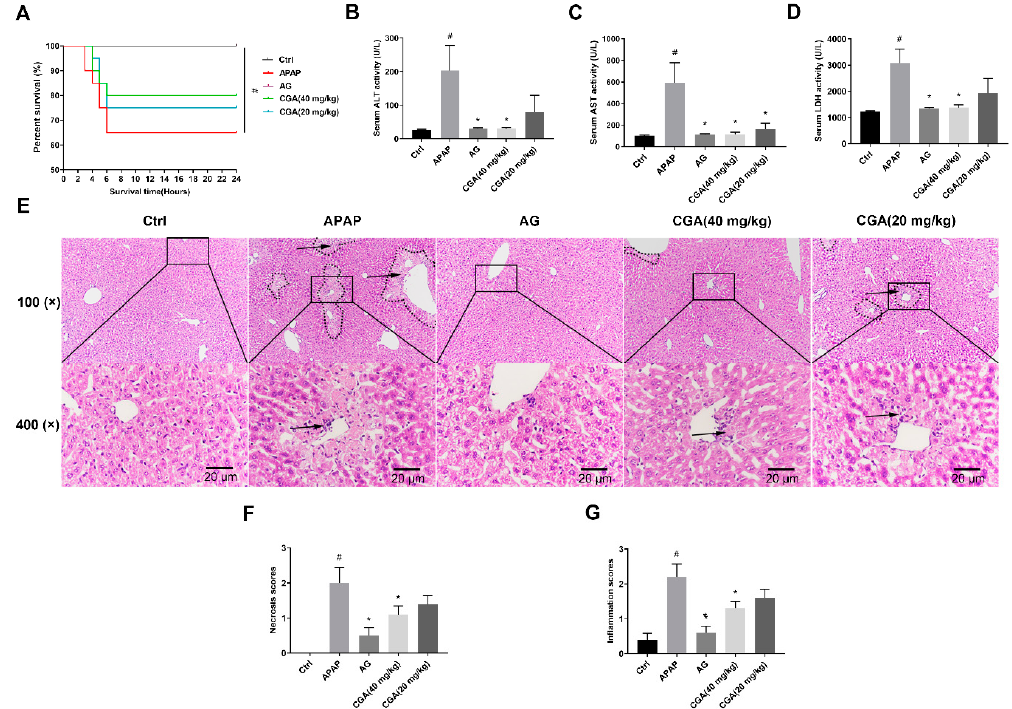
Figure 3. CGA alleviated hepatotoxicity in APAP ‐ induced mice. ( A ) 24 h survival rate of APAP ‐ induced liver injury mice (log ‐ rank test, n = 20). ( B – D ) Serum levels of ALT, AST, and LDH ( n = 5). ( E ) Microscopic pictures of the H&E ‐ stained hepatic sections ( n = 5, scale bar = 20 μ m); the arrows indicate leukocyte infiltration and the dotted line represents the necrotic area. ( F ) Histological necrosis scores ( n = 5). ( G ) Inflammation scores ( n = 5). Data are displayed as mean ± S.E.M. # p < 0.05 vs. Ctrl group; * p < 0.05 vs. APAP group.